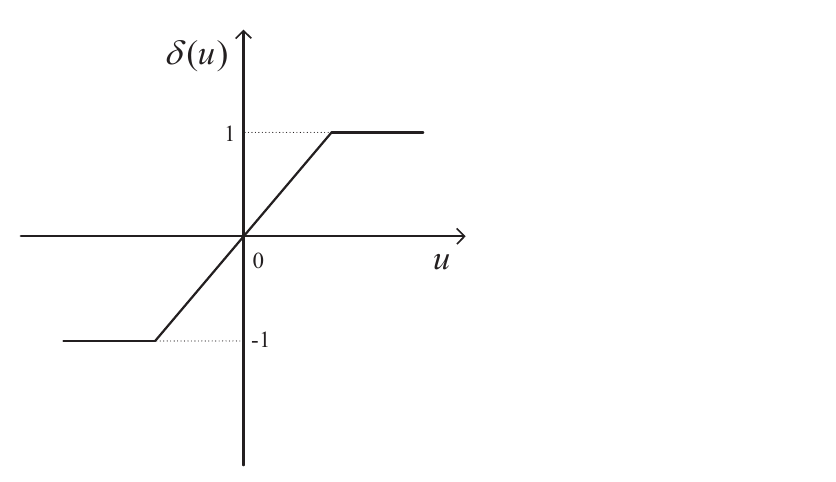
Figure 1. Standard saturation function.